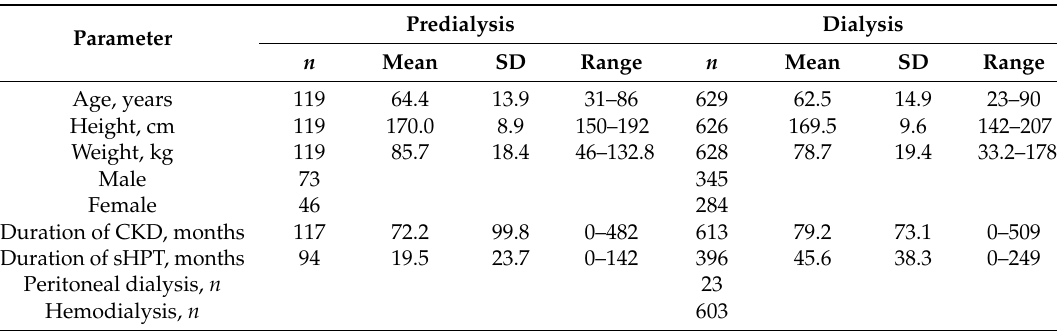
Table 1. Demographic